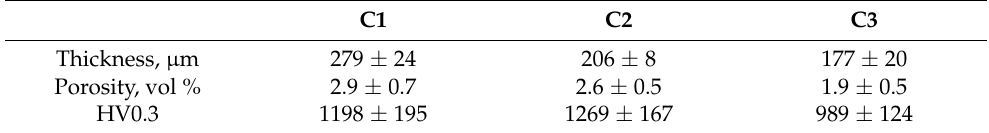
Table 2. Average thickness, porosity and microhardness of deposited coatings.